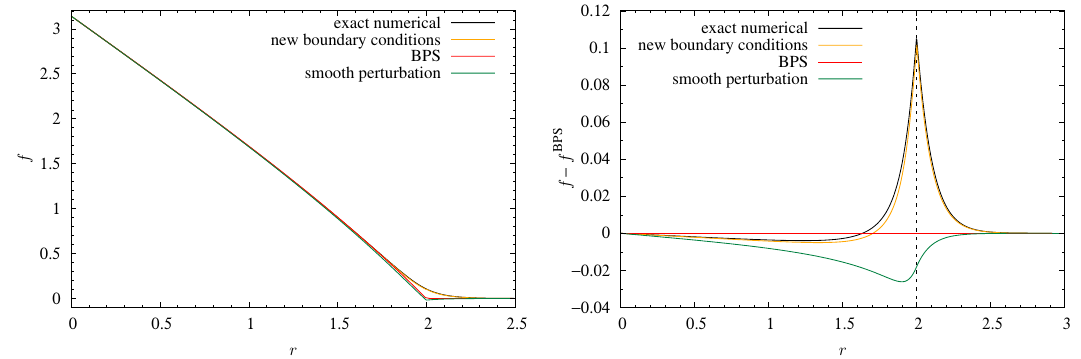
Figure 1 . The profile function f = arccos( φ 3 ) for N = 1 and (cid:15) = 0 . 01 with m = 1 . The BPS background profile function is shown as a red solid curve. The smooth perturbation (dark-green curve) does not capture the kink at the compacton radius r = R = 2 . The perturbation subject to the new boundary condition (3.90) (orange) on the other hand lies very close to the exact numerical solution